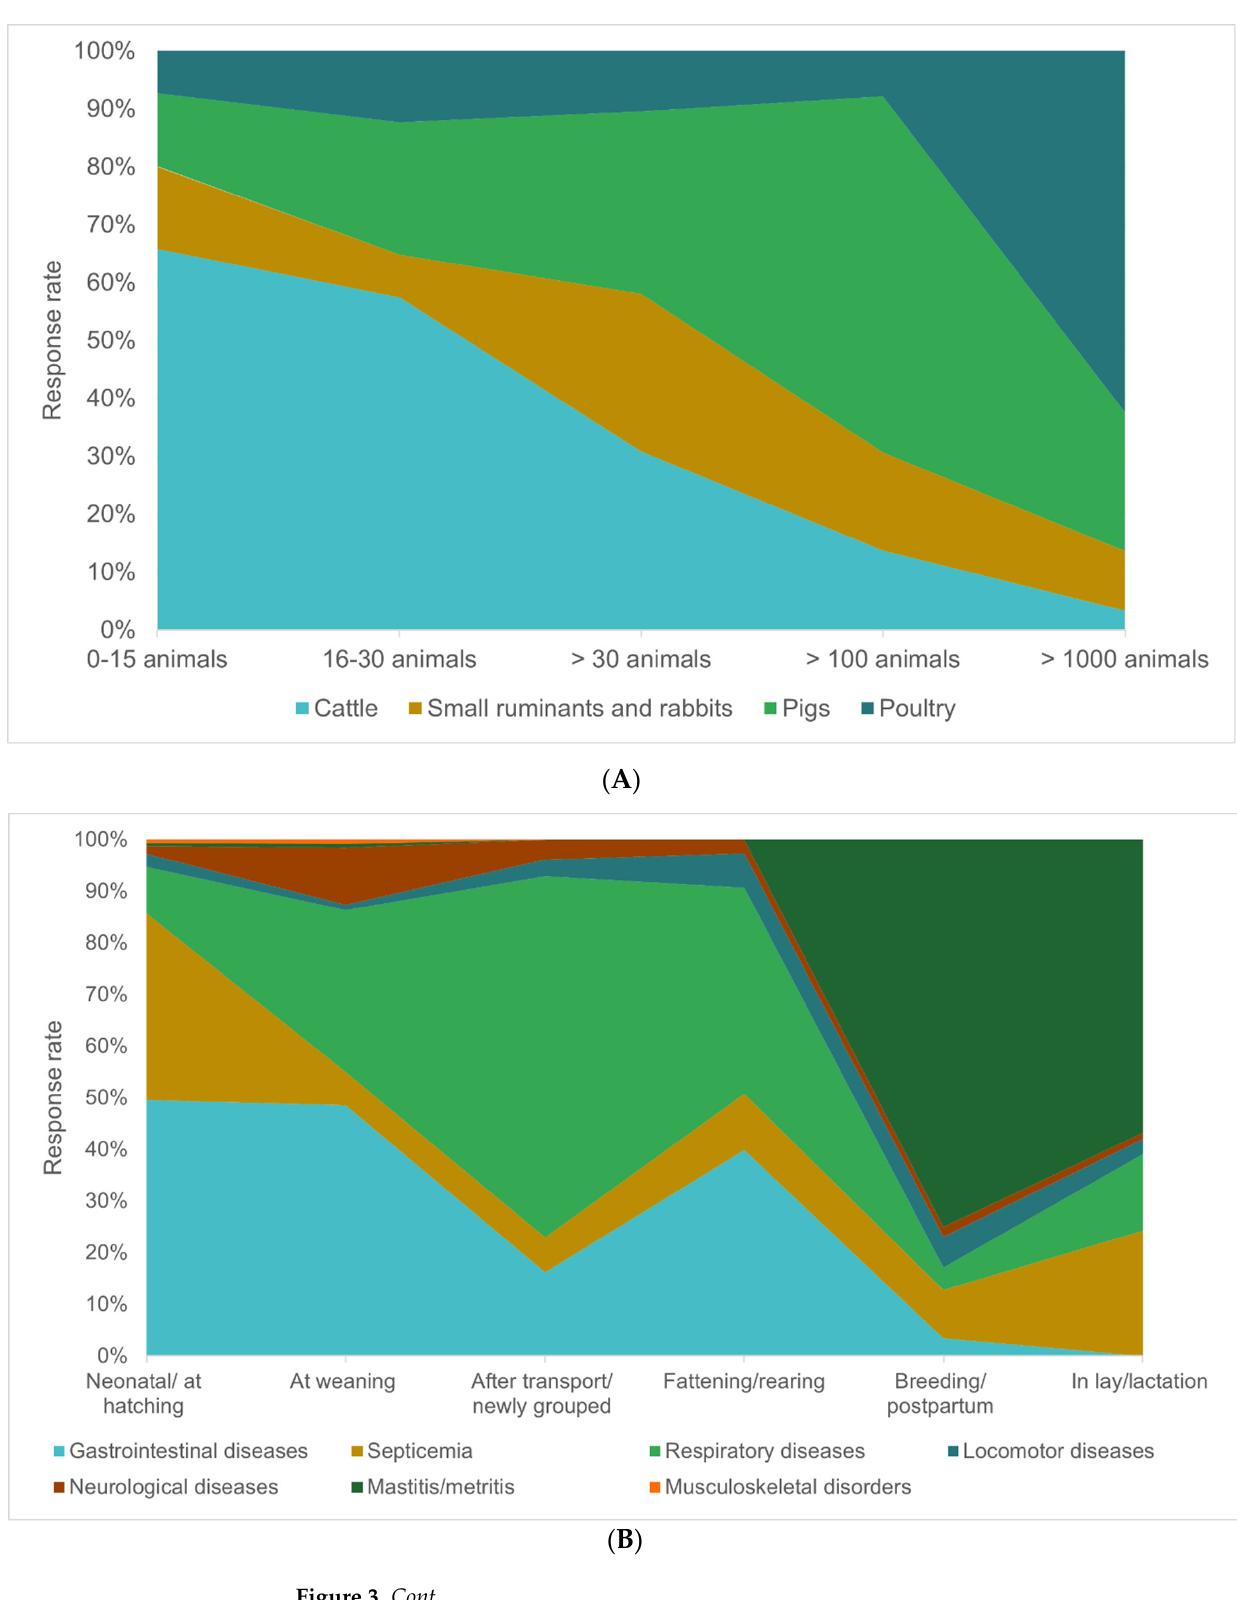
( C ) Figure 3. Most frequent models for metaphylactic treatment as indicated by responding veterinari ‐ ans in percent (x ‐ axis). ( A ): species (cattle, pigs, small ruminants and rabbits, poultry) and group size in five categories (0–15 animals, 16–30 animals, >30 animals, >100 animals, >1000 animals.) ( B ): stage of production (neonatal/ at hatching, at weaning, after transport/ newly grouped, fatten ‐ ing/rearing, breeding/ postpartum, in lay/lactation) and disease (gastrointestinal diseases,